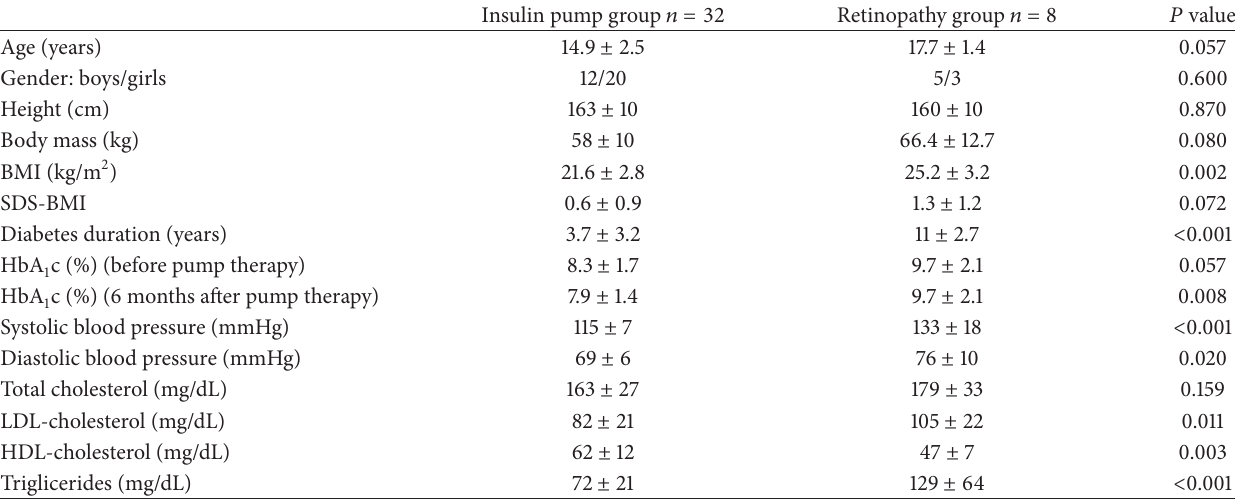
Table 1: General characteristics of the insulin pump group and retinopathy